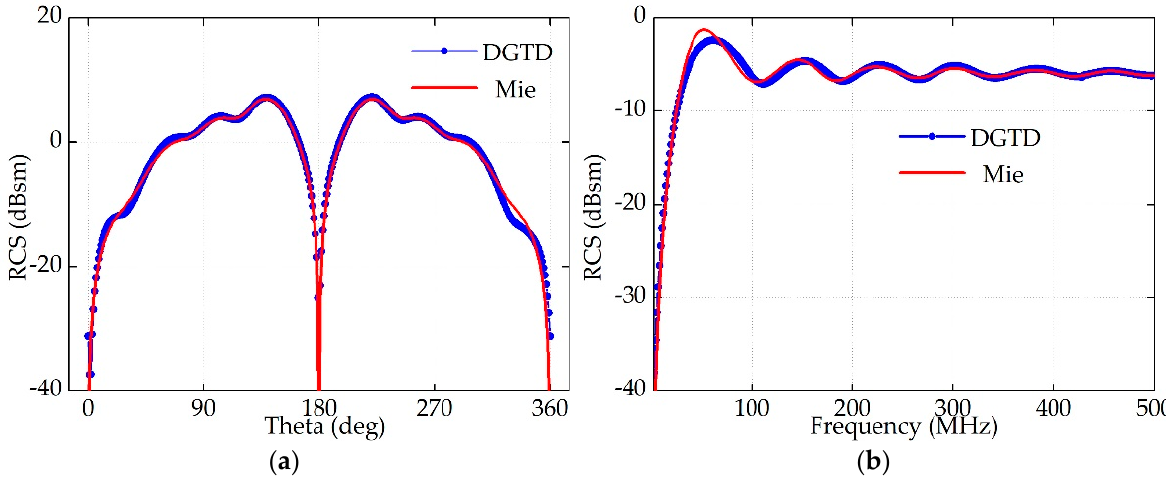
Figure 5. Bistatic radar cross section (RCS) of a perfect electrically conducting (PEC) sphere computed through DGTD and Mie at ( a ) 0.3004 GHz, and ( b ) the electric field of a PEC sphere computed through DGTD and Mie at range of frequencies from 0.1 to 500 MHz.